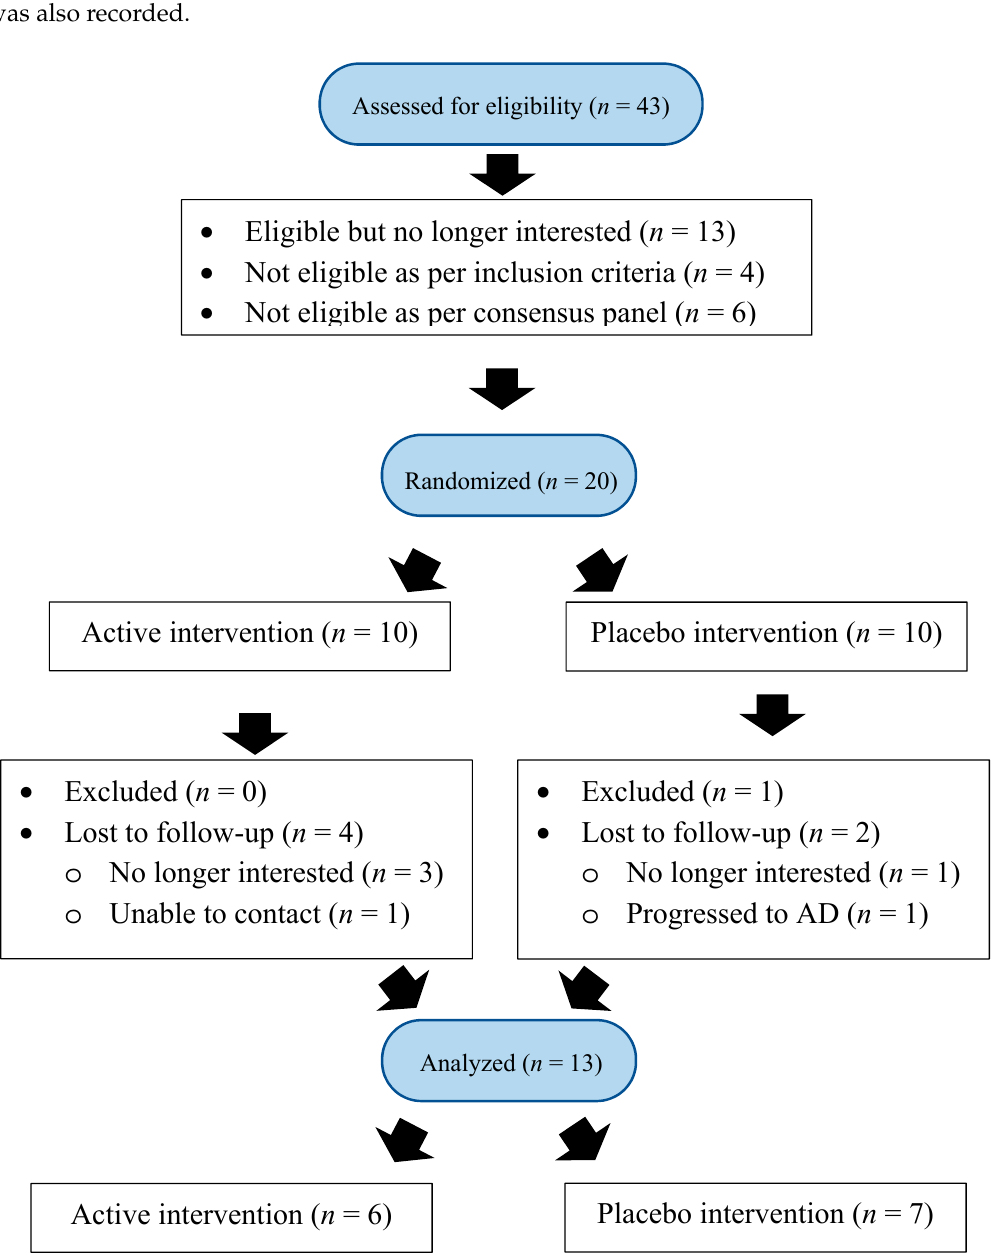
Figure 1. Consolidated Standards of Reporting Trials (CONSORT) flow diagram for the Cognitive impAiRmEnt Study (CARES) Trial 1.